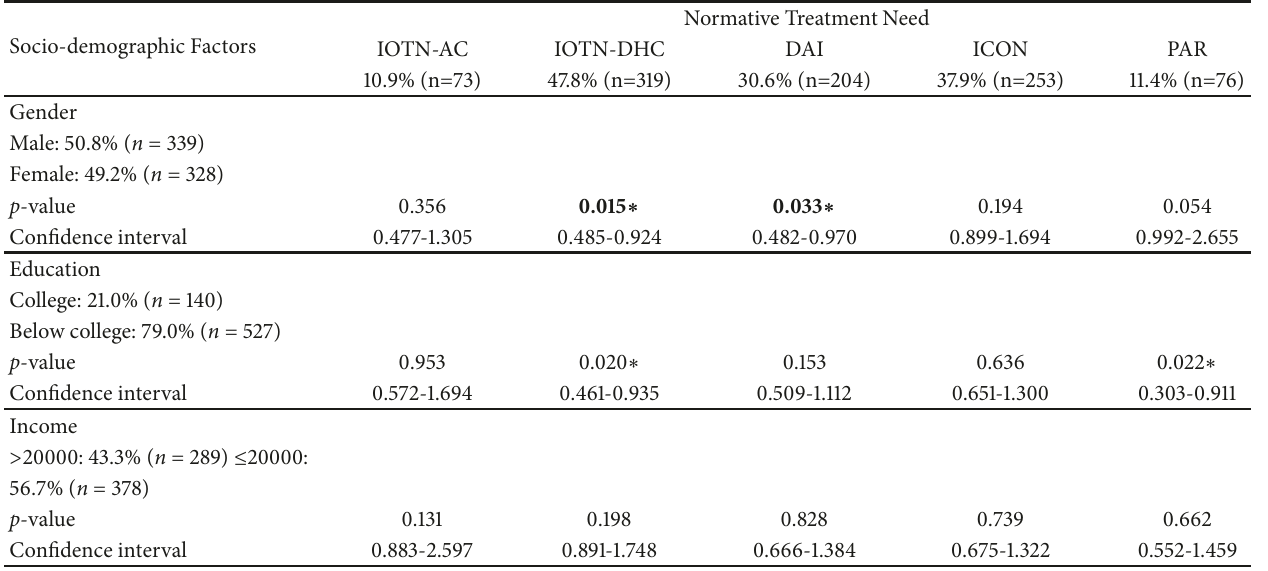
Table 4: Associations between normative treatment need and sociodemographic factors.